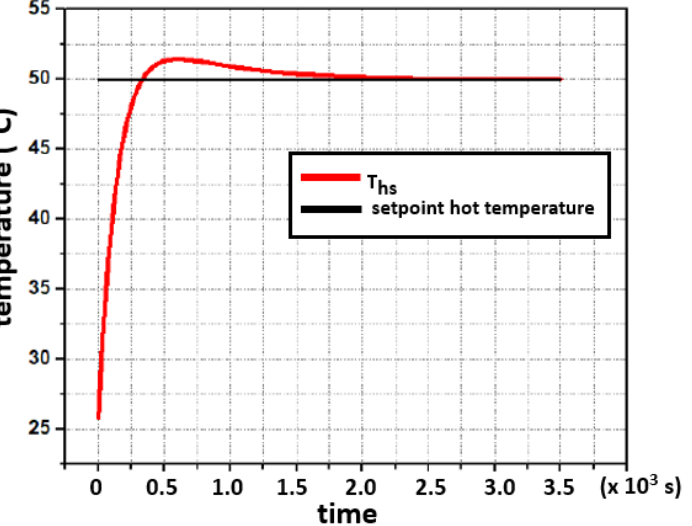
Figure 10. Simulated closed-loop response for a setpoint of 50 ◦ C at the hot side with a starting temperature of 26 ◦ C.